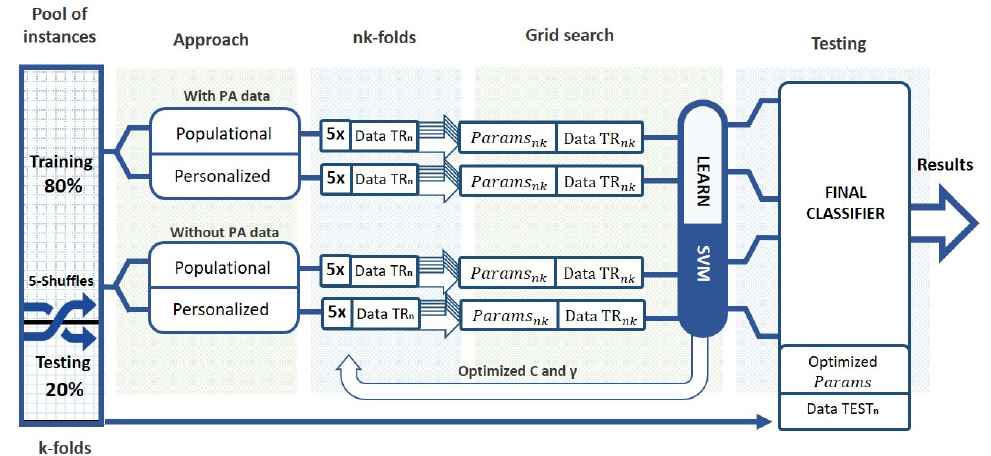
Figure 2. General diagram of the methodology employed to build the machine learning models.